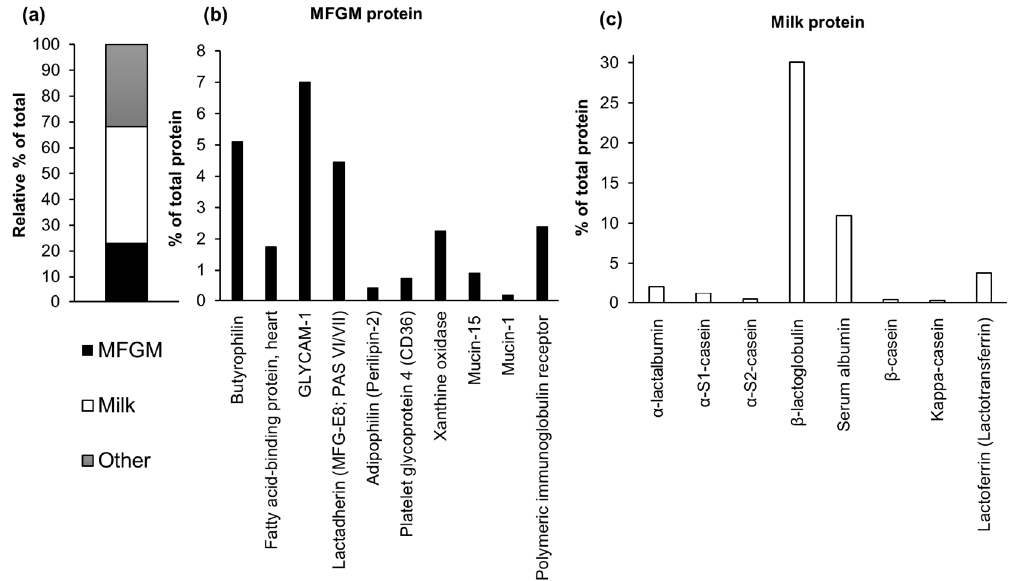
Figure 4. ( a ) Proteomics of whey protein phospholipid concentrate (WPPC), in which various protein abundances are expressed as a relative percentage of total protein. Proteins are divided into three groups: “MFGM proteins”, “milk proteins”, and “other proteins”. ( b ) Relative percentages of the milk fat globule membrane (MFGM) proteins in whey protein phospholipid concentrate (WPPC). ( c ) Relative percentages of milk proteins in whey protein phospholipid concentrate (WPPC).